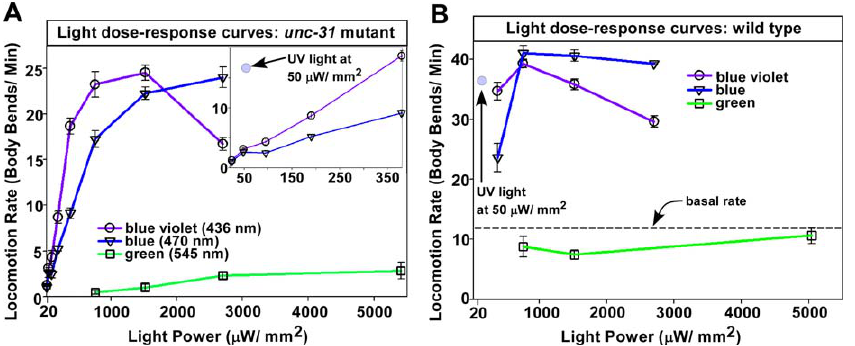
Figure 2. The Relationship of Light Dose to Locomotion Rate at Various Wavelengths (A) Mean locomotion rate of the unc-31(e928) mutant at various powers and wavelengths of light. The highest power for each color is close to the maximum power of that color that we can project onto the culture plate. The maximum power of green light causes only a weak response. The inset expands the low power region of the graph and shows the strong response to UV light at a power where blue and blue-violet light cause only weak responses. Error bars in (A) and (B) are the standard errors in populations of ten animals. (B) Response of N2 (wild type) to various powers and wavelengths of light. A dashed line indicates N2 9 s basal rate in low power white light (70 nW/ mm 2 ). Note that low power UV light causes a response greater than a 7-fold higher power of blue or blue-violet light. Note that green light does not cause a significant locomotion response, even at the highest power.